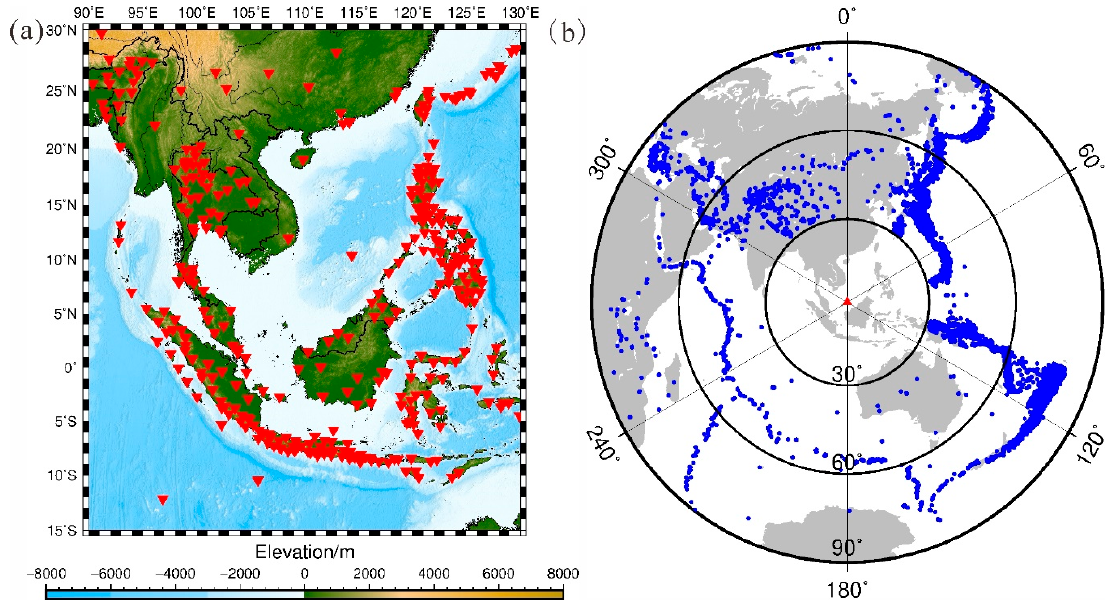
Figure 2. ( a ) Distribution of 394 seismic stations in the South China Sea (SCS) and surrounding areas; ( b ) Distribution of seismic sources for teleseismic tomography imaging of 14,011 teleseismic events.